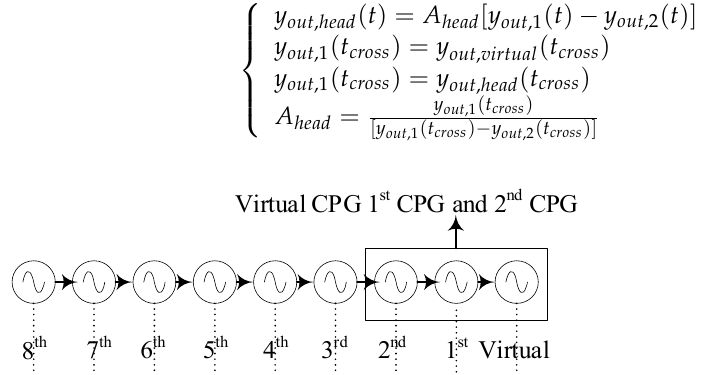
Add a virtual CPG signal in the CPG network to calculate the head navigation angle, as shown in Figure 4. According to (3), the correction signal is y out of the head joint, the head in the head navigation motion is calculated by the output of the first CPG ( y out , 1) and the second CPG ( y out , 2). The final calculation model is: